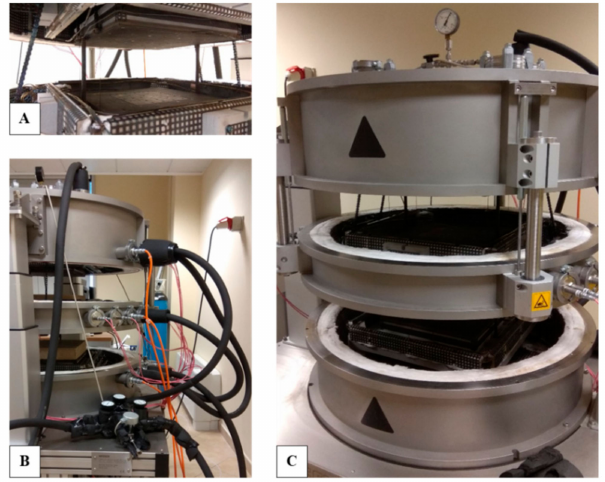
Figure 6. GHP 456 Titan: ( A ) focus on a hot plate and guard ring (below), cold plate (above); ( B ) thermocouples and insulated pipes for N2; ( C ) open-system